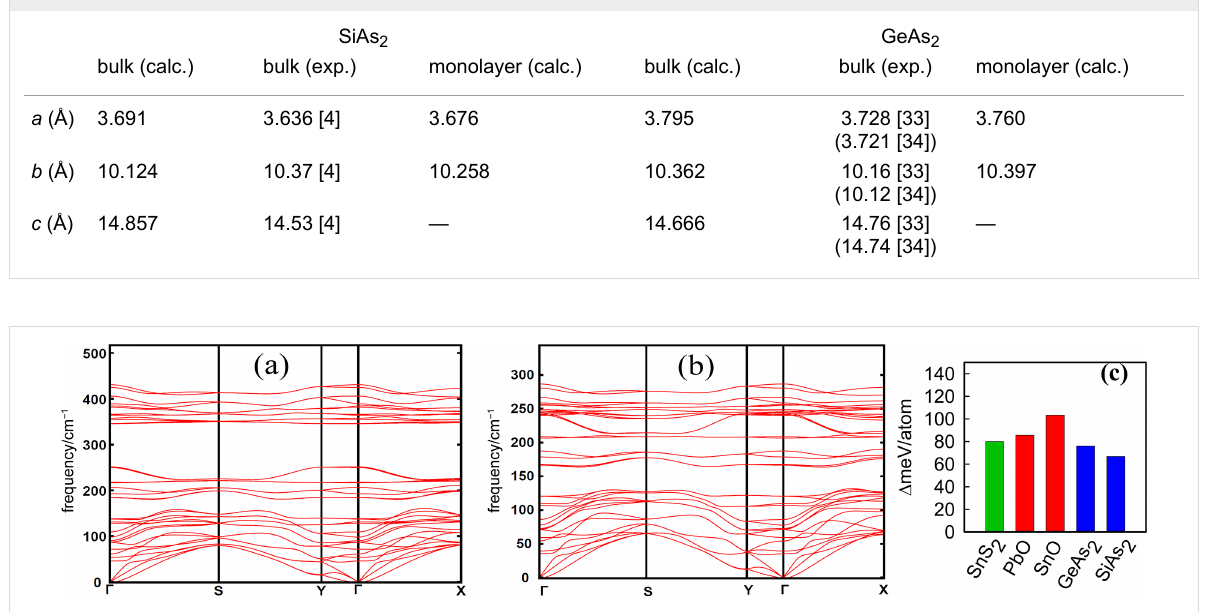
Table 1: Calculated structural parameters of SiAs 2 and GeAs 2 compared with the experimental values. SiAs 2 bulk (calc.)